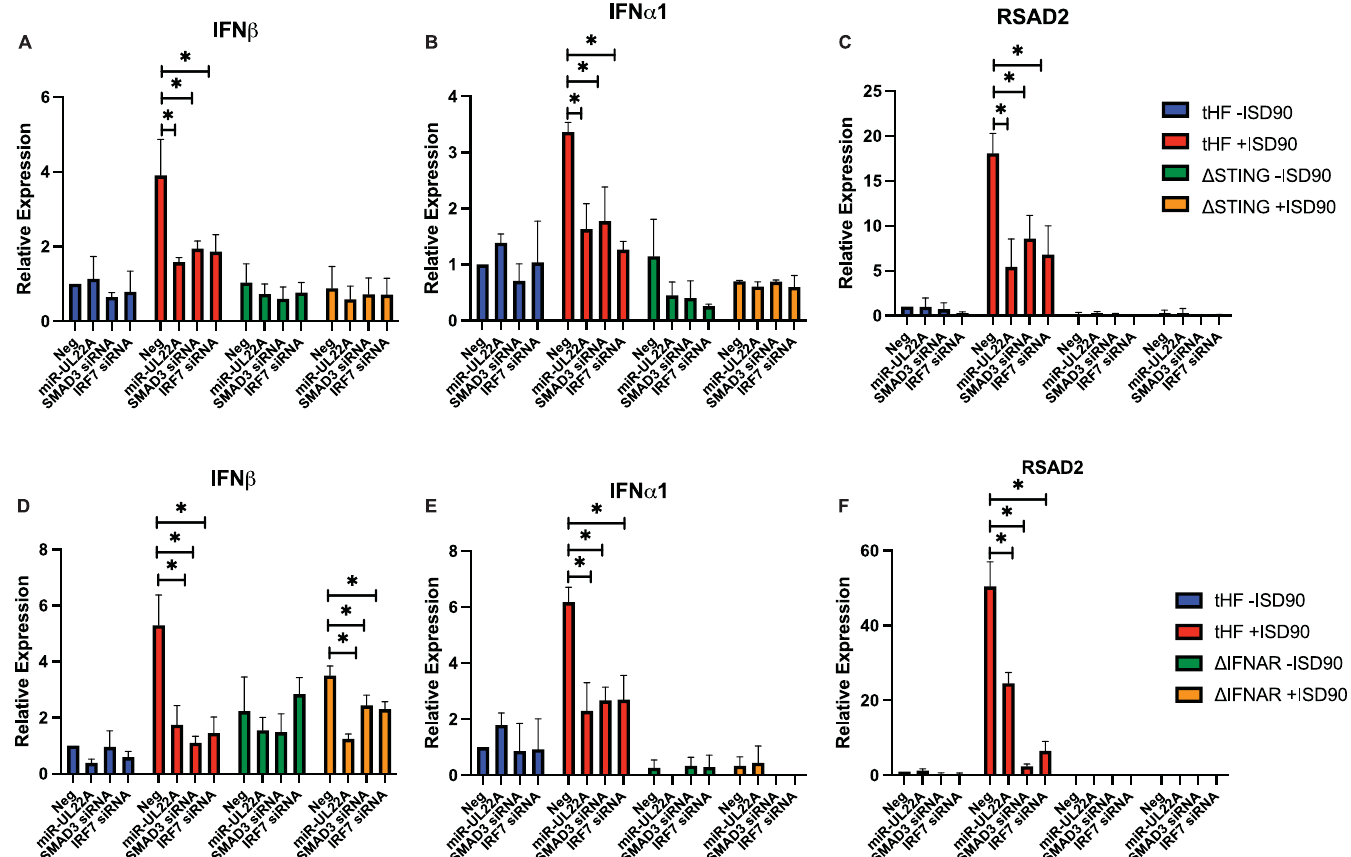
Fig 5. SMAD3 participates in STING- and IFN receptor-mediated signaling. tHF, Δ STING (A-C) or Δ IFNAR (D-F) tHFs were transfected with negative control, miR-UL22A mimic or SMAD3 or IRF7 siRNA for 48 hours after which cells were additionally mock transfected or transfected with ISD90 for 16 hours. RNA was isolated and subjected to qRT-PCR for IFN β , IFN α 1 or RSAD2. All experiments were performed in triplicate. � p < 0.05 by two tailed Student’s t test.